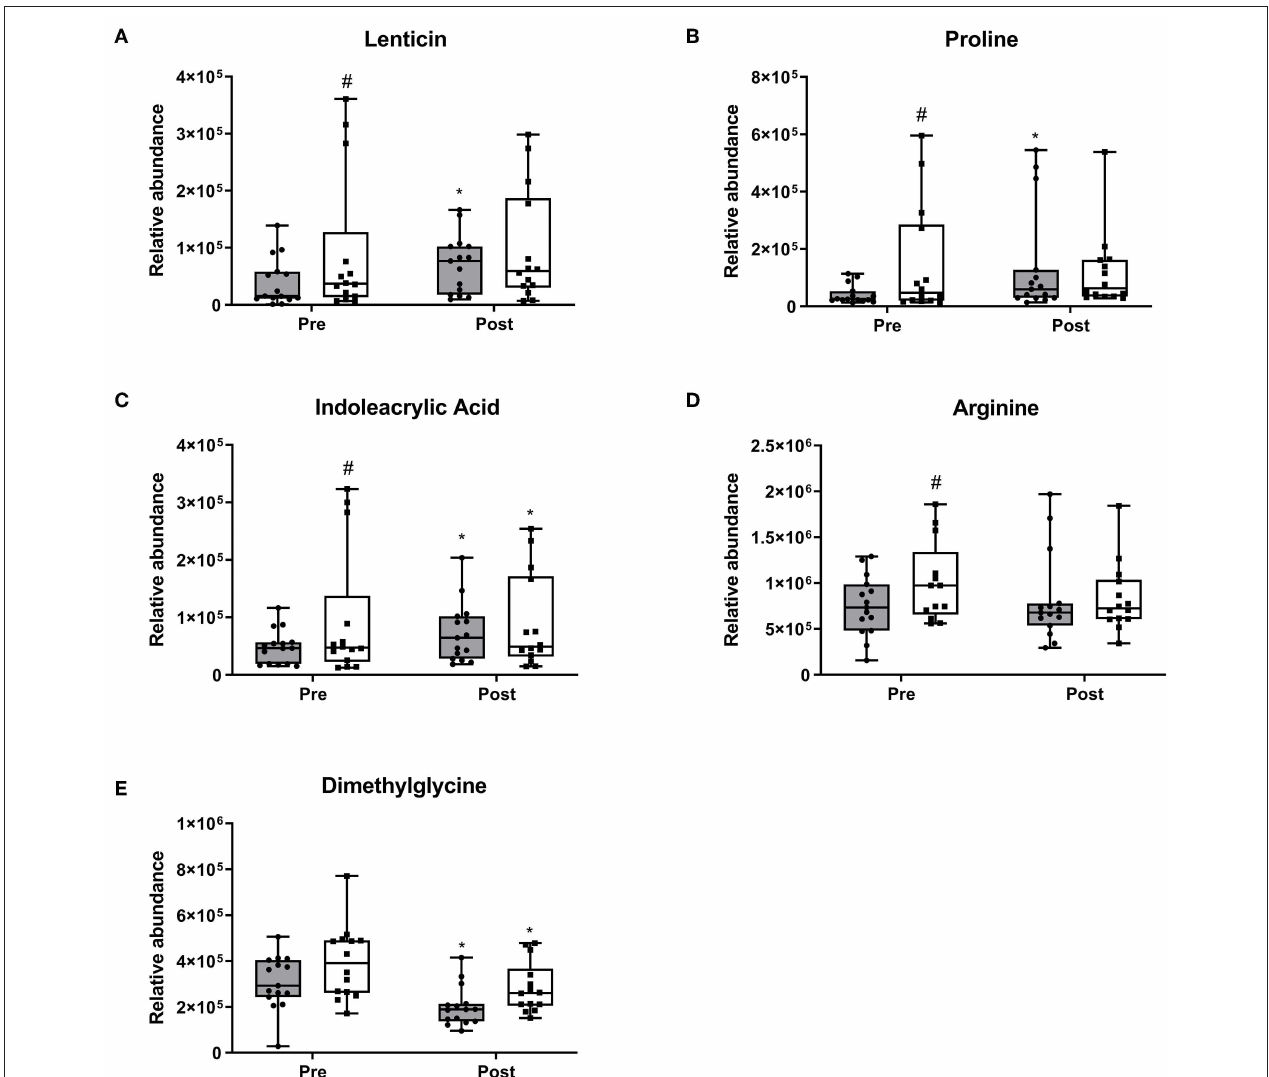
FIGURE 4 | Pre-intervention metabolite differences. Box and whisker plots show median, first, and third quartiles, and maximum and minimum values. There were four metabolites which exhibited pre-intervention differences (A) lenticin, (B) proline, (C) indoleacrylic acid, and (D) arginine. (E) dimethylglycine decreased in both diet groups. # denotes the significant differences of metabolites between 2RDA and RDA. *Represents the significant differences between pre and post-intervention within each